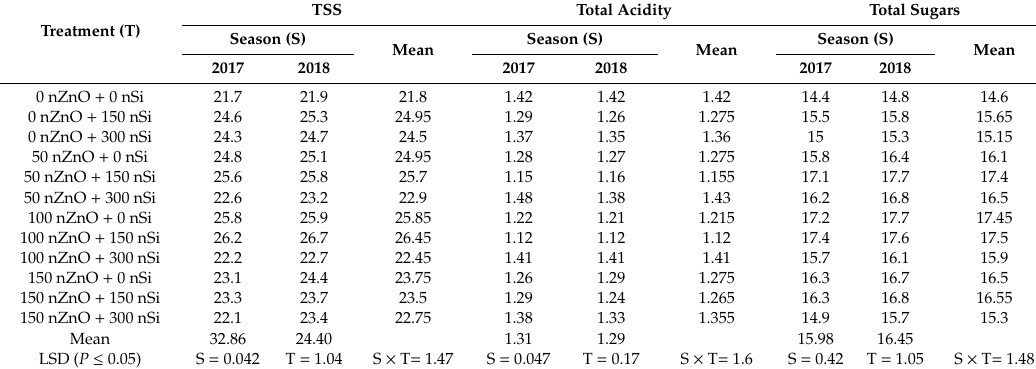
Table 8. E ff ect of foliar spray with ZnO and Si NPs (mg / L) on the fruit total soluble solids (TSS) (%), total acidity (g citric acid / 100 mL juice), and total sugars (g / 100 g pulp) of “Ewais” mango trees during the 2017 and 2018 seasons. Treatment